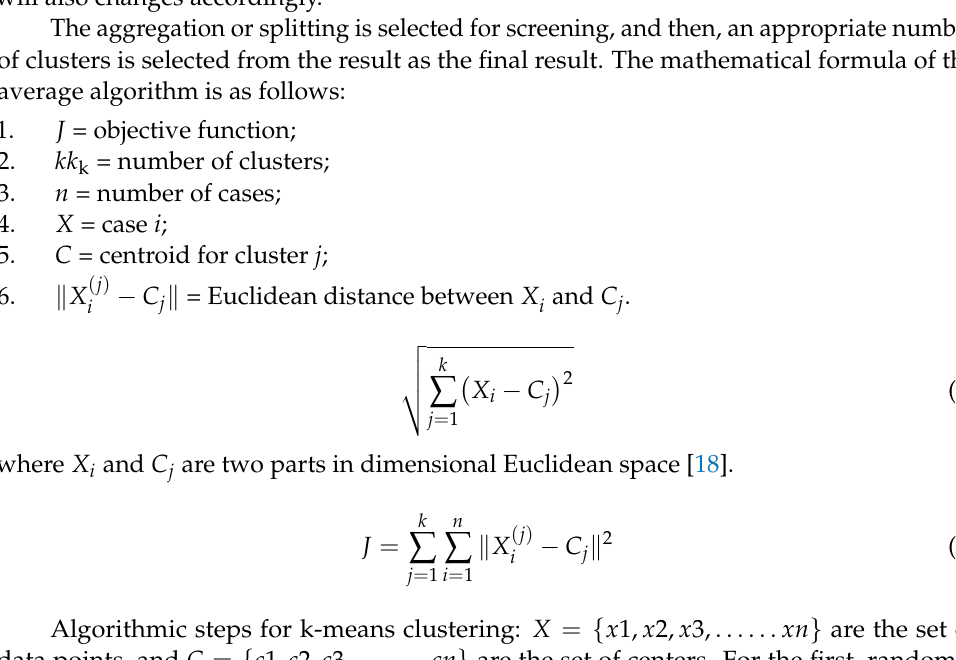
Algorithmic steps for k-means clustering: X = { x 1, x 2, x 3, . . . . . . xn } are the set of